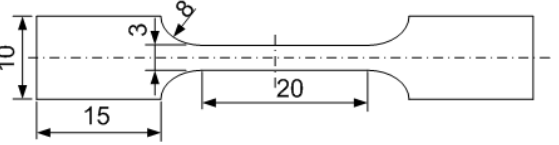
Figure 1. Geometry of the samples used for tensile tests. Dimensions are provided in